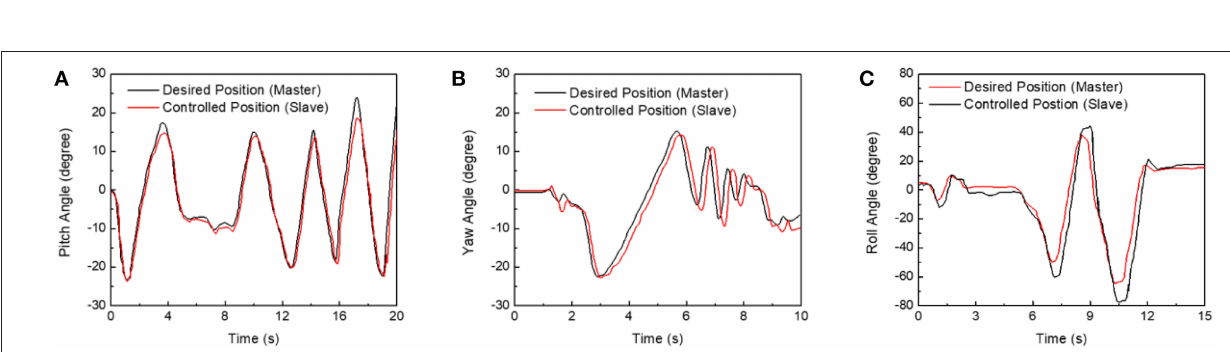
FIGURE 11 | Position tracking control results. (A) Pitch motion. (B) Yaw motion. (C) Roll Motion.